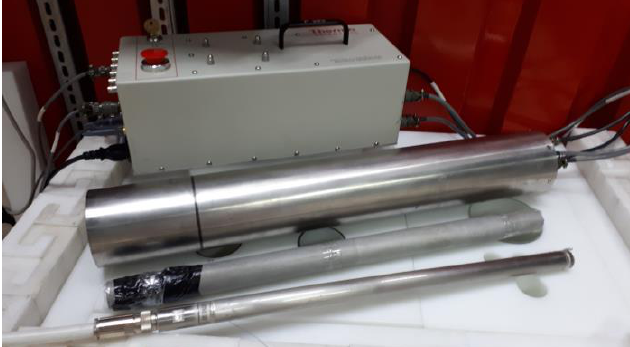
Fig. 3. Geometry used in calculations The neutron generator was placed to the centre of the geometry. The generator internals were modelled in detail based on the input provided by the tube producer. The detectors assumed in calculations were He-3 tubes with active length of 20 cm, diameter of 2.5 cm, and with helium pressure in the tube of 2 bars. The centre of the detectors was placed 10.5 cm from the centre of the tube (neutron source position); vertically the centre of the detector corresponds to the source plane. Only active volumes of the detectors were simulated. In case A (moderated geometry), the generator was placed inside PE block of 50 x 50 x 100 cm; the detectors were placed in dry channels with diameter of 7 cm. One detector was simulated as bare, another was covered by 1 mm thick cadmium sheet with density of 8.65 g/cm 3